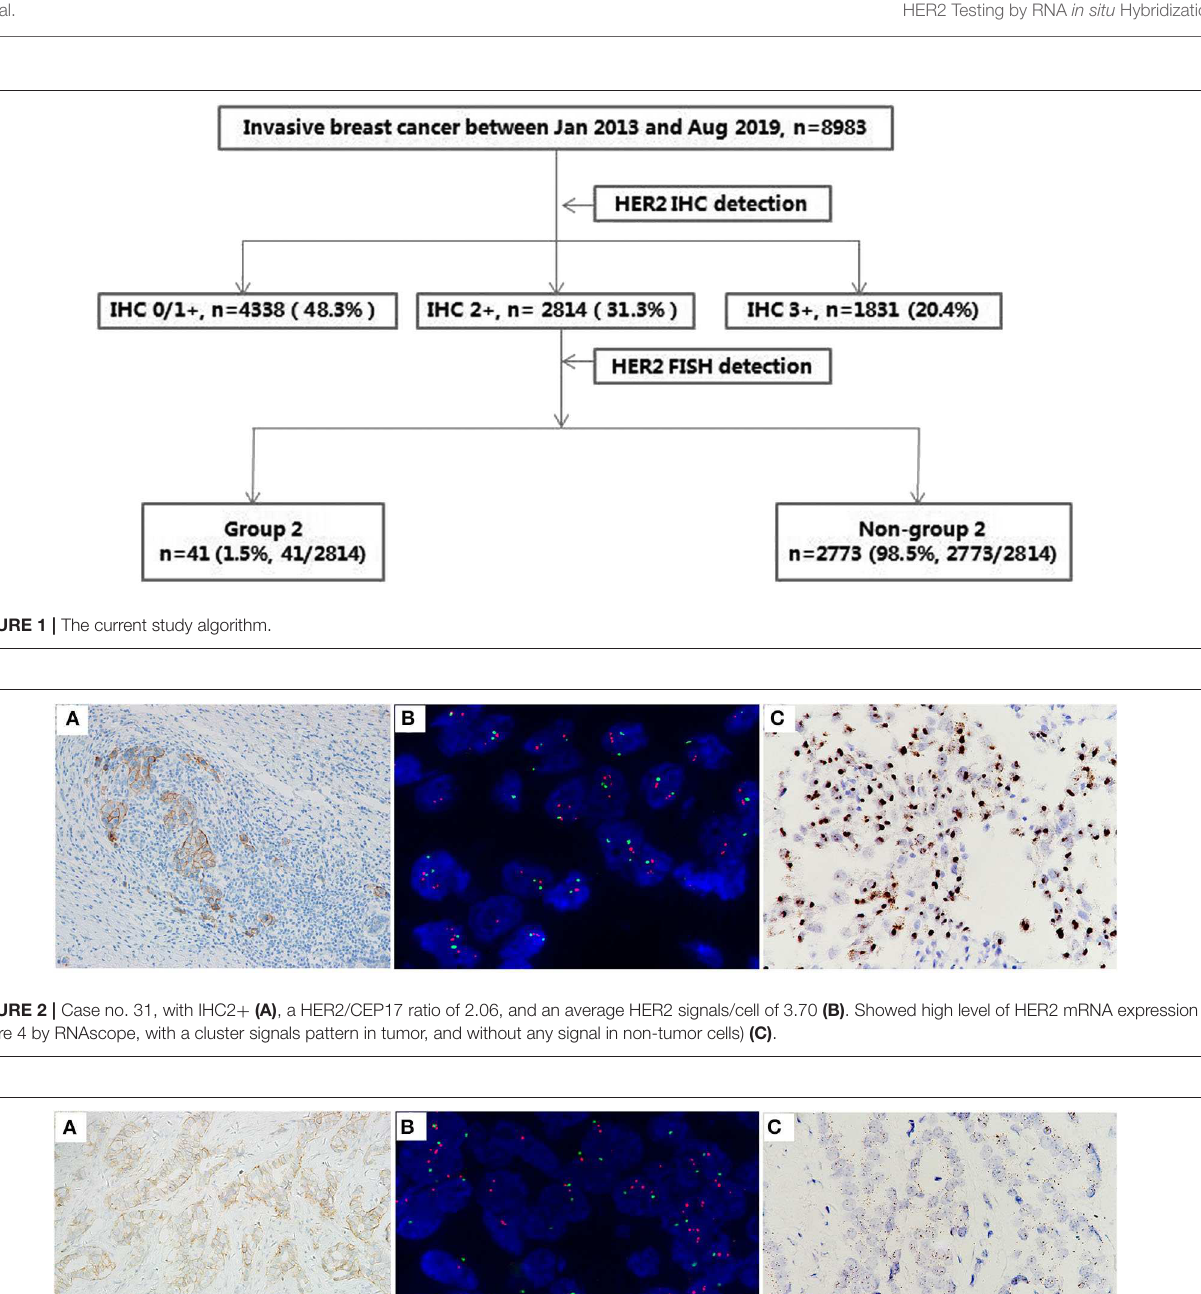
RNAscope), possessed the highest (90%) and lowest (5%) Ki 67 indexes, respectively. The lowest HER2 mRNA expression with a score of 1 by RNAscope, was found in 12 cases, including case nos. 6, 8, 12, 16, 21, 22, 23, 27, 29, 30, 33, and 34, with the average HER2 signals/cell being 3.90, 2.10, 3.20, 3.65, 3.70, 3.40, 3.93, 3.55, 2.25, 3.90, 3.48, and 3.70, respectively. Case no. 34,